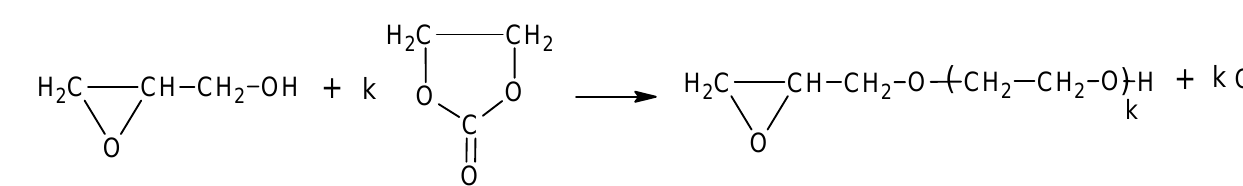
Figure 4. 1 H-NMR spectra of polyols (CS + H 2 O + GL) + EC ( a ), (CS + GLYC + GL) + EC ( b ), (CS + GL) + EC ( c ), and (CS + GL + EC) ( d ).